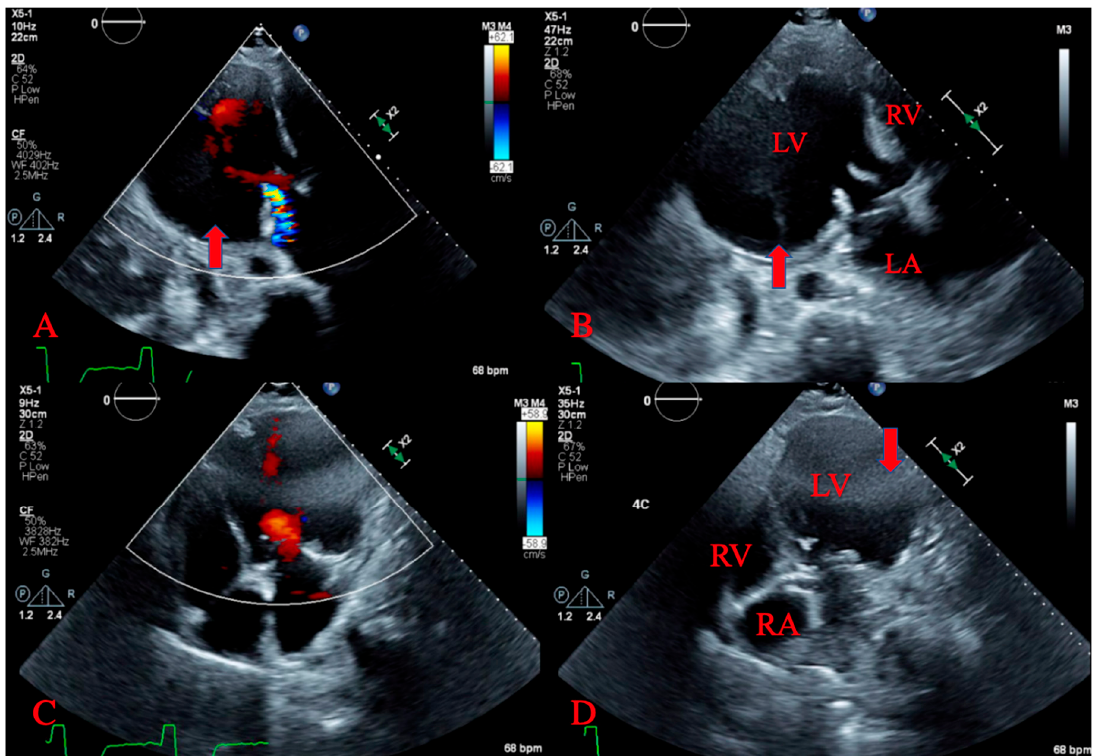
Figure 3. Transthoracic echocardiogram. ( A , B ) demonstrating left ventricular pseudoaneurysm with to and fro flow. ( C , D ) showing large loculated pericardial effusion.